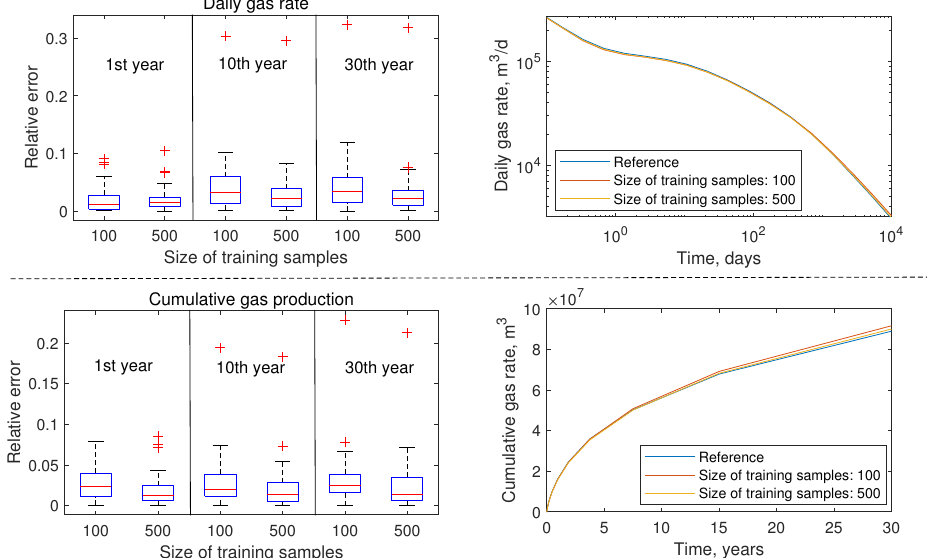
Figure 8. Relative error box diagram of machine learning model and time series prediction results of daily and cumulative shale gas production.